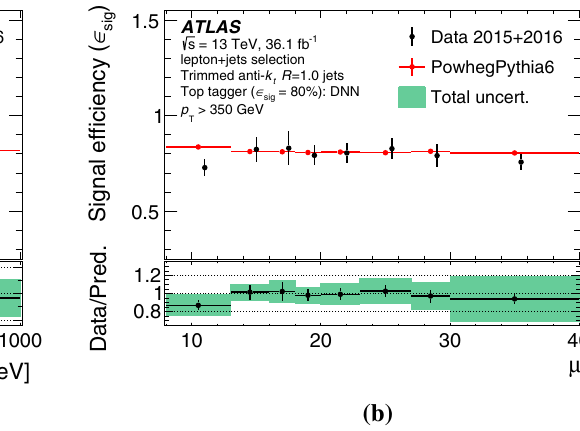
Fig. 20 The signal efficiency on contained top-quark jets for the jet shape-based DNN top-quark tagger as a function of the large- R jet p T ( a ) and the average number of interactions per bunch crossing μ ( b ) in data and simulation. Statistical uncertainties of the signal efficiency measurement in data and simulation are shown as error bars in the top panel. In the bottom panel, the ratio of the measured signal efficiency